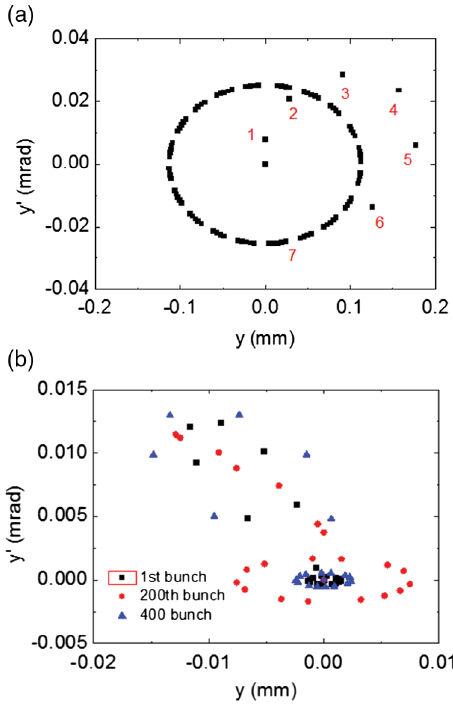
FIG. 4. Stored-beam motion in phase space at the location of the septum magnet. (a) Oscillation due to the septum leakage field. (b) Oscillation suppression by the